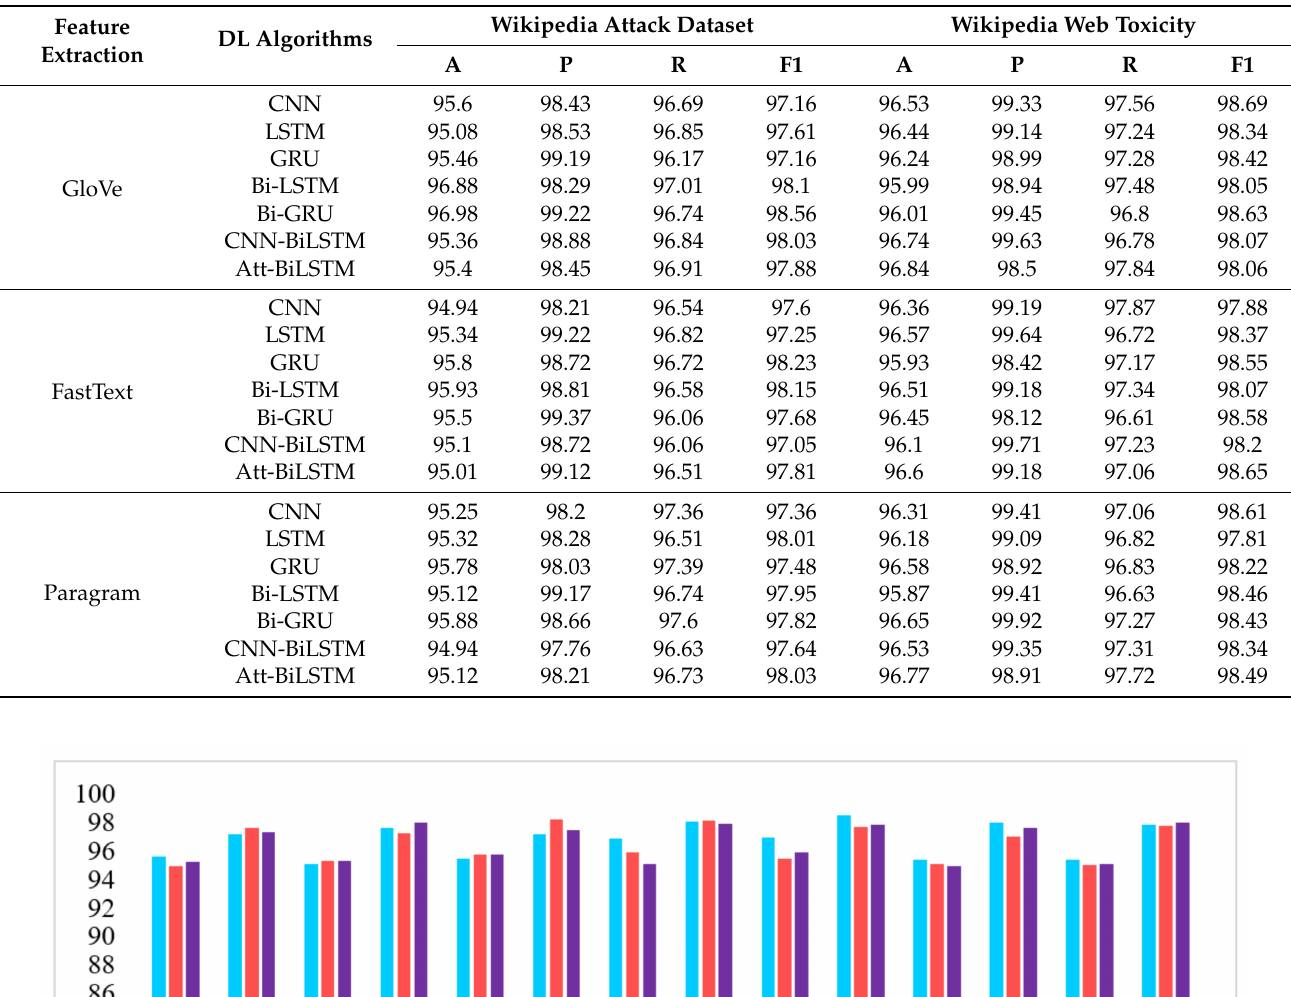
Table 2. Results of seven shallow neural networks with three embedding techniques on two datasets.